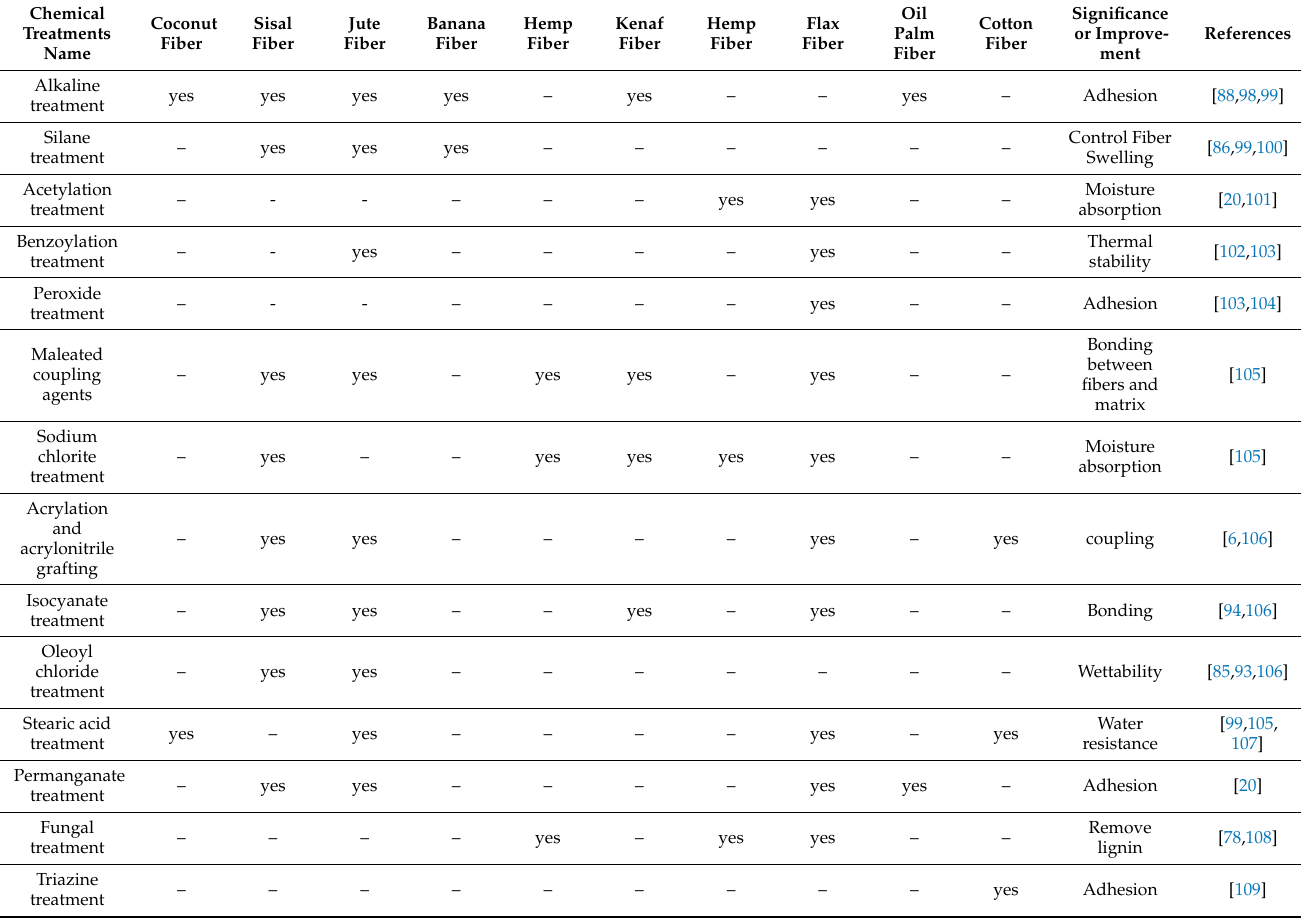
Table 2. Different chemical treatments and their effect on natural fibers.